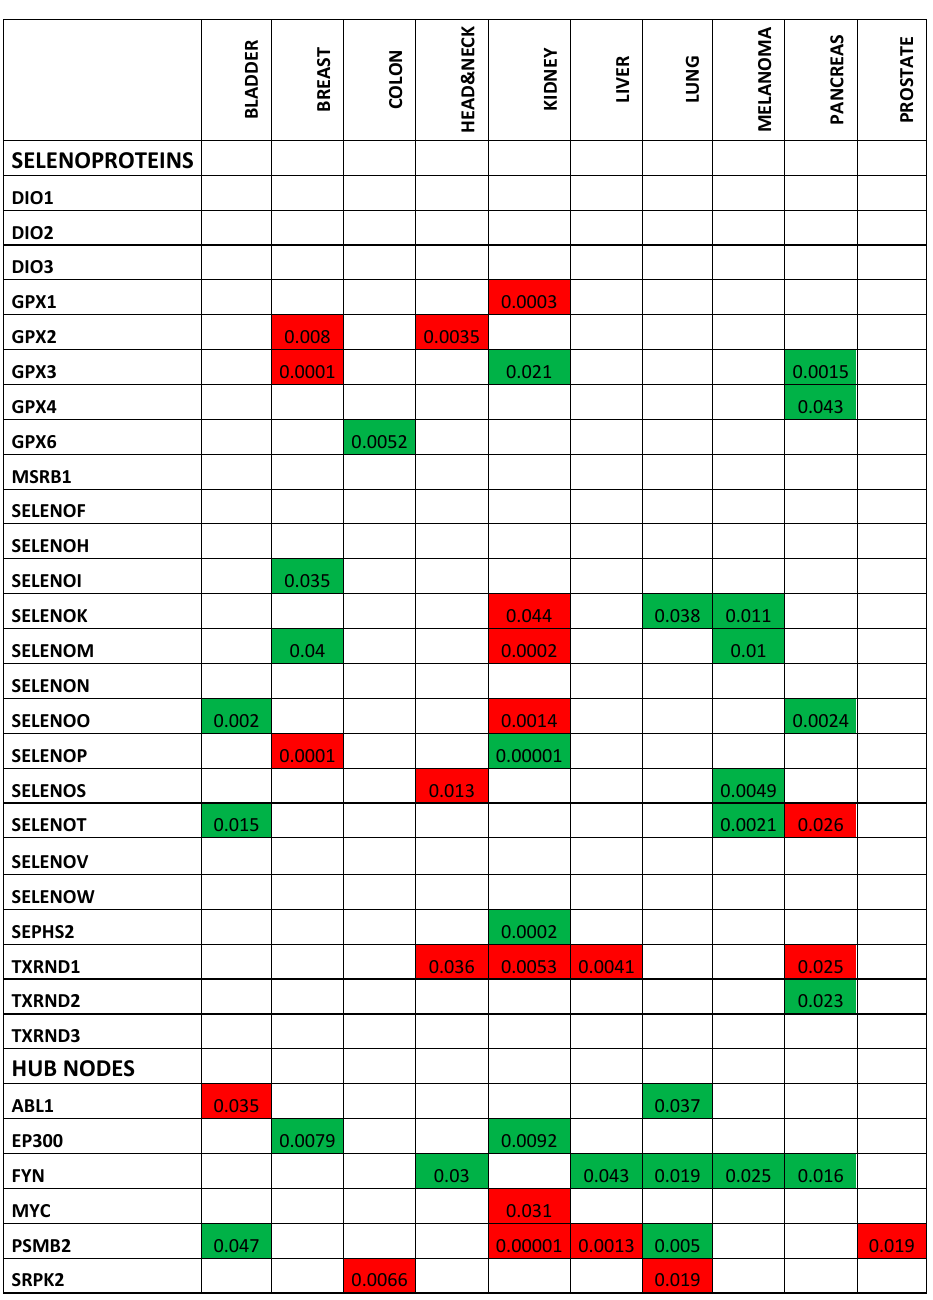
Figure 2. Heat map related to the statistically significant correlations (with p -values < 0.05) between overall survival (OS) in solid tumor patients and selenoprotein / HUB node expression. In detail, we report significant p -values in red or in green, if the high or low expression of selenoproteins, was correlated with poor overall survival, respectively. White boxes indicate no significant